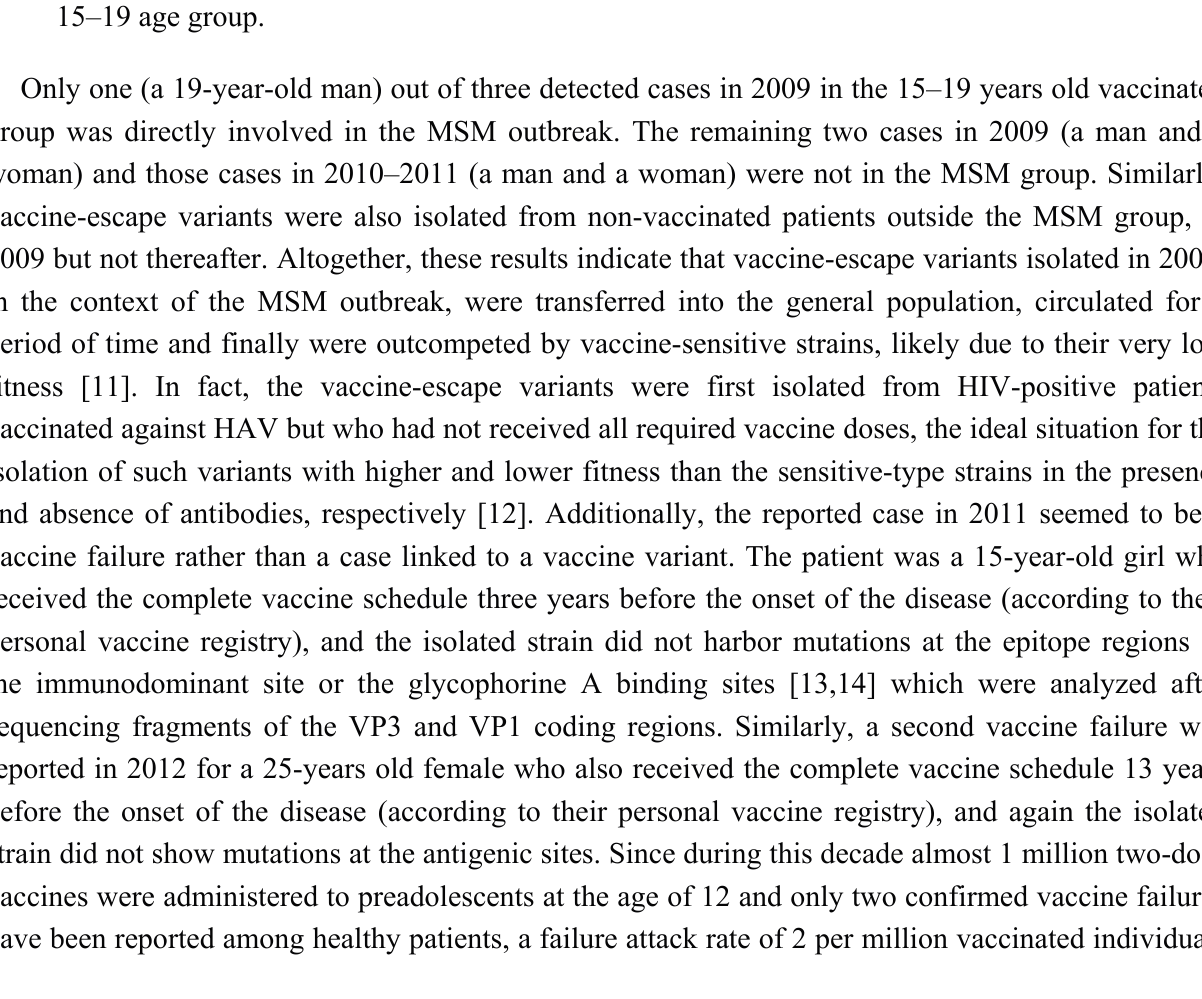
Figure 3. Hepatitis A attack rate of the 15–19 age group during the 2009–2013 period in Catalonia, Spain, in the context of a universal vaccination campaign for preadolescents at the age of 12 years. The 15–19 age group mostly includes young adults who have been vaccinated. Attack rates are defined as the number of cases per 100,000 inhabitants of the 15–19 age